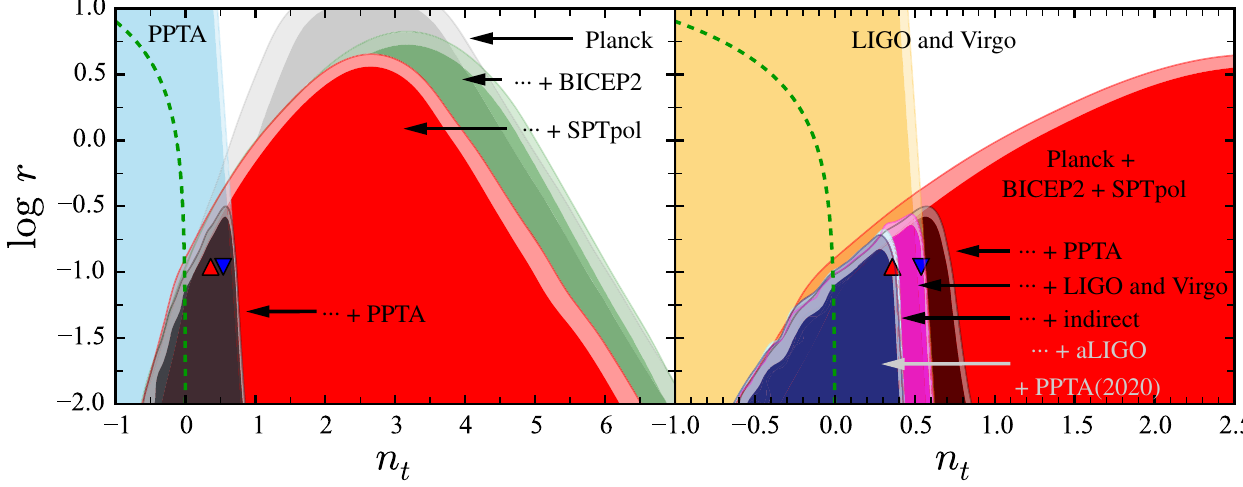
FIG. 2. Combined, two-dimensional posterior distribution for the tensor-to-scalar ratio r , and the blue tilt of the GW spectrum n t , using CMB, PPTA, indirect, and LIGO observations. The contours are the 95% and 99% limits. The green, dashed curve shows the consistency relation, n t ¼ − r= 8 , while the red and blue triangles correspond, respectively, to the red and blue curves in Fig 1. For clarity, the right-hand panel is a zoomed-in version of the left-hand panel, with additional posterior distributions shown. See Sec. III A for a description of each posterior distribution.